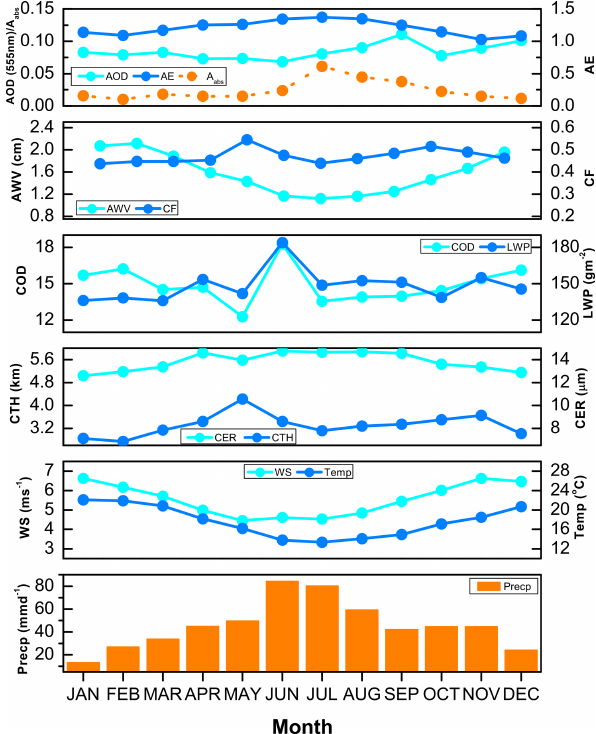
Figure 13. Intercomparison of average monthly variation of aerosol (AOD, AE, A abs ), AWV, cloud (CF, LWP, COD, CTH, CER), and meteorology (WS, TEMP, PRECP) parameters over lower South